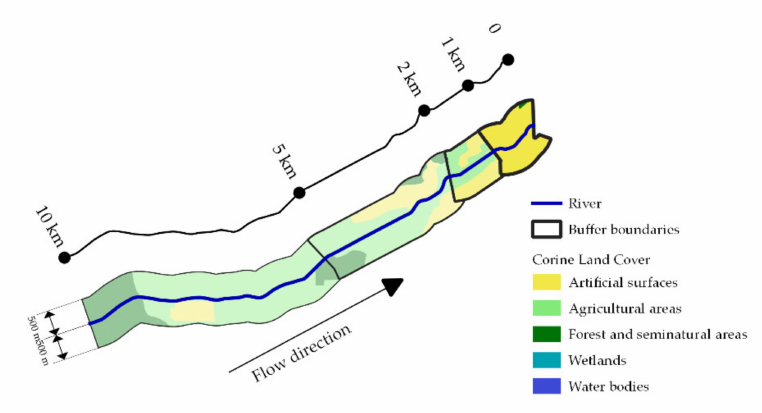
Figure 5. Scheme of buffer zones for land-cover